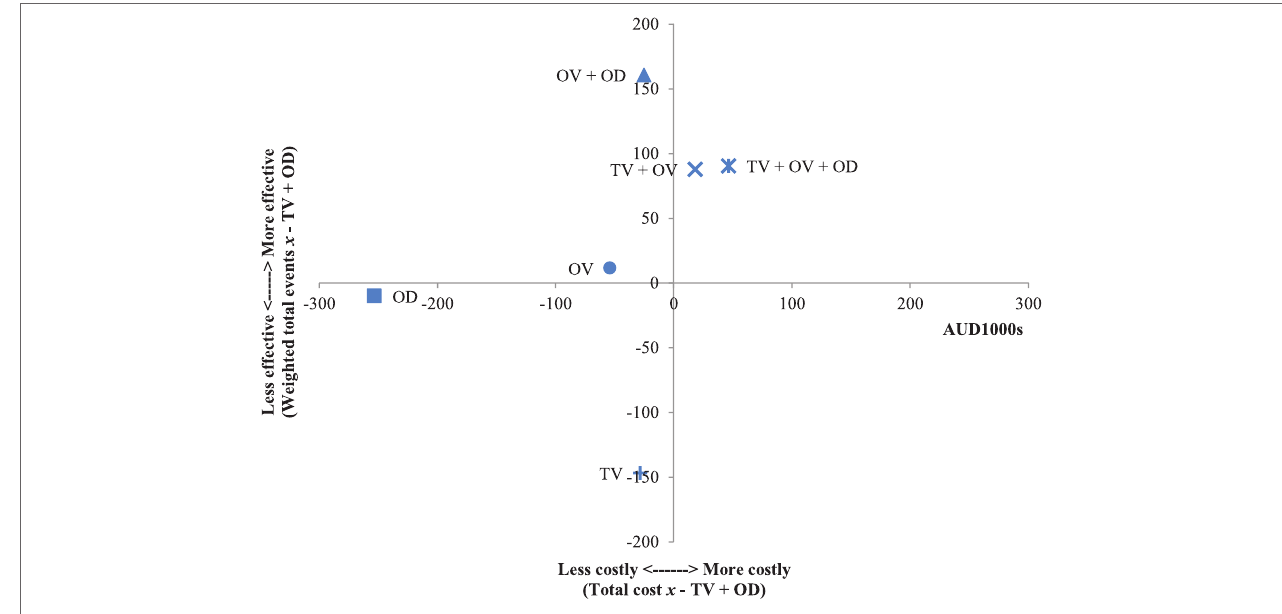
FiguRE 5 | Incremental cost-effectiveness of each format compared with television (TV) + online display (OD). The cost-effectiveness of TV + OD forms the baseline (cross-section of x and y axes). Effectiveness is weighted total events of each format ( x ) compared with TV + OD. Cost is total costs in AUD1,000s of each format ( x ) compared with TV + OD. Data points that fall in the upper left quadrant represent formats that are more cost-effective than TV + OD.